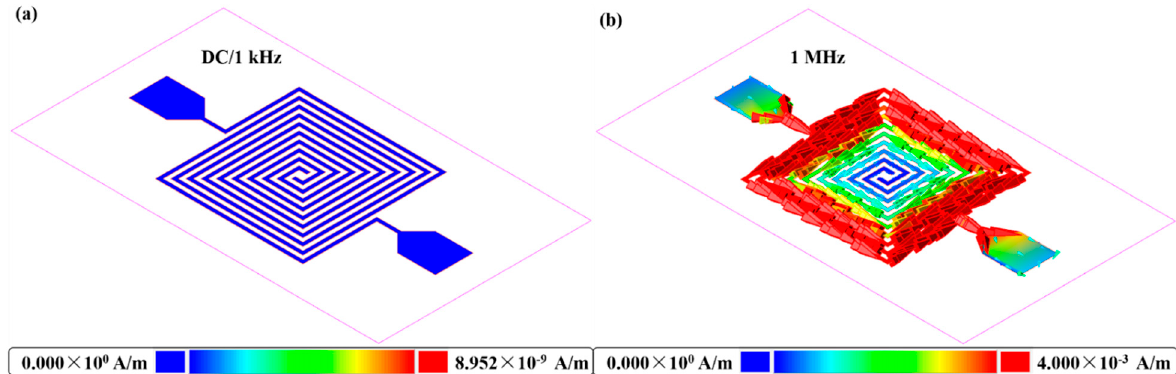
Figure 7. Current density diagram of the capacitor-based biosensor: ( a ) At DC and 1 kHz signal frequency; ( b ) at 1 MHz signal frequency. Table 2. Performance comparison with other previously reported methods.